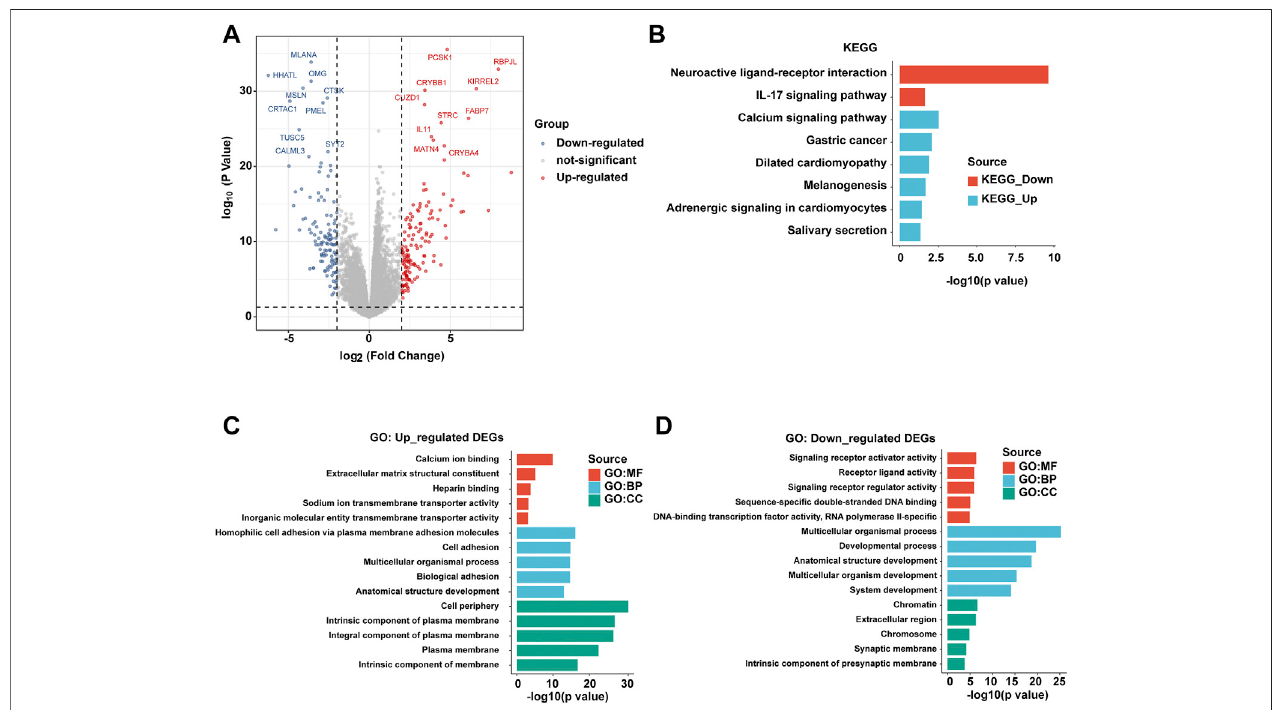
FIGURE 4 | Analysis of differential gene expressions (DEGs) between PBhiPMhi and PBloPMlo groups. (A) Volcanic map shows the DEG distribution of HCC patientsinthePBhiPMhigroupandPBloPMlogroup. (B) KEGGfunctionalenrichmentanalysisofDEGsinpatientswithHCC; (C,D) GOfunctionalenrichmentanalysisof DEGs in patients with